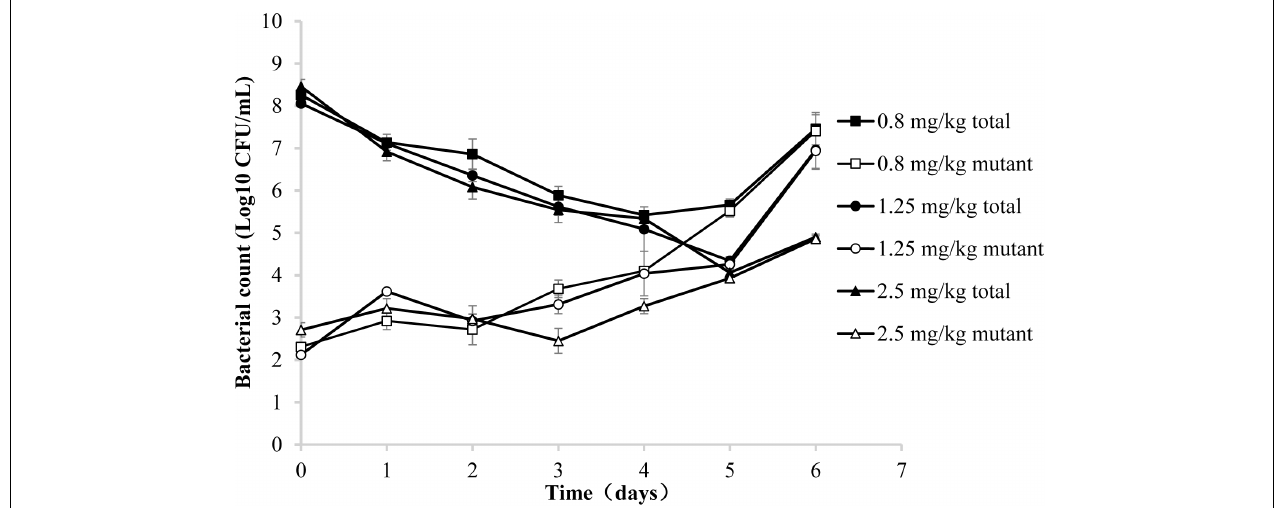
FIGURE 2 | Recovery of total and resistant bacteria after administration of danofloxacin at 0.8, 1.25, and 2.5 mg/kg. Concentrations of total bacteria and resistant mutants were determined in aliquots of tissue cage fluid obtained at the indicated time points after the initiation of treatment. Three representative examples are shown for piglets in which the danofloxacin concentrations were located between the MIC 99 and